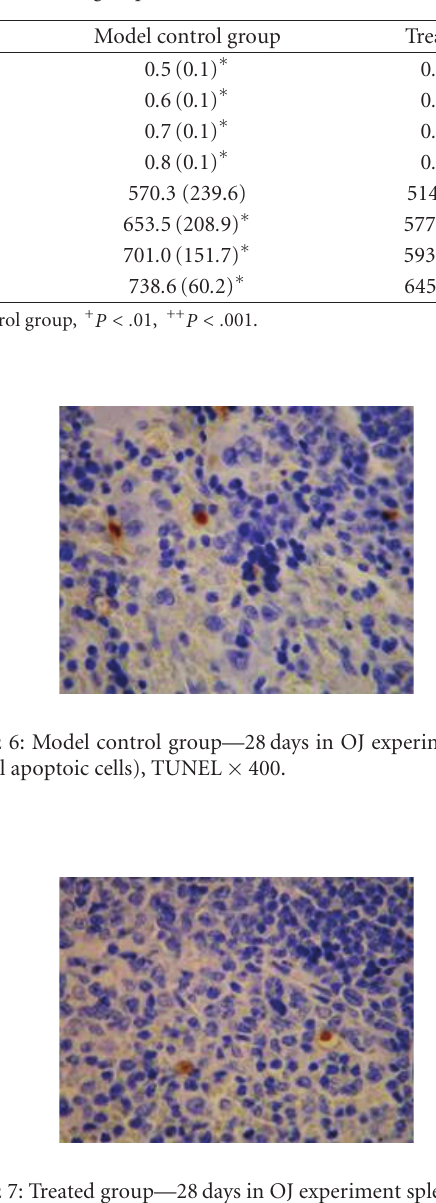
Figure 7: Treated group—28 days in OJ experiment spleen (several apoptoic cells), TUNEL ×